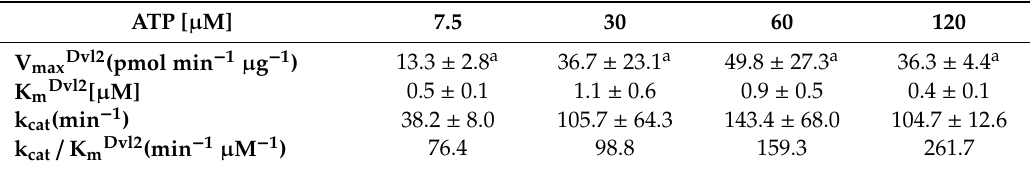
Table 7. Representation of kinetic parameter values of CK1 ε obtained as a function of varying DVL2 concentrations at fixed ATP